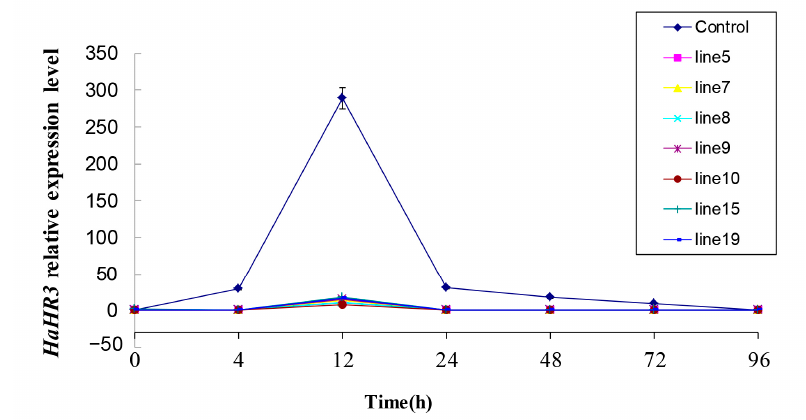
Figure 6. The relative expression of HaHR3 in H. armigera . qRT-PCR analysis of HaHR3 expression. HaHR3 relative expression levels in H. armigera fed on transgenic cotton (lines 5, 7, 8, 9, 10, 15, and